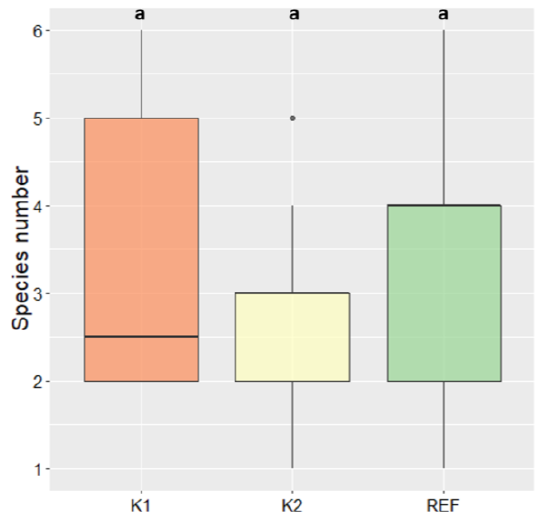
Figure 3. Ectomycorrhizal (ECM) species number from 20 Norway spruce seedlings per forest type in K1, the forest attacked by bark beetle; K2 forest destroyed by bark beetle; REF mature forest. The diagrams represent median, quartiles, and range (1.5 × IQR).